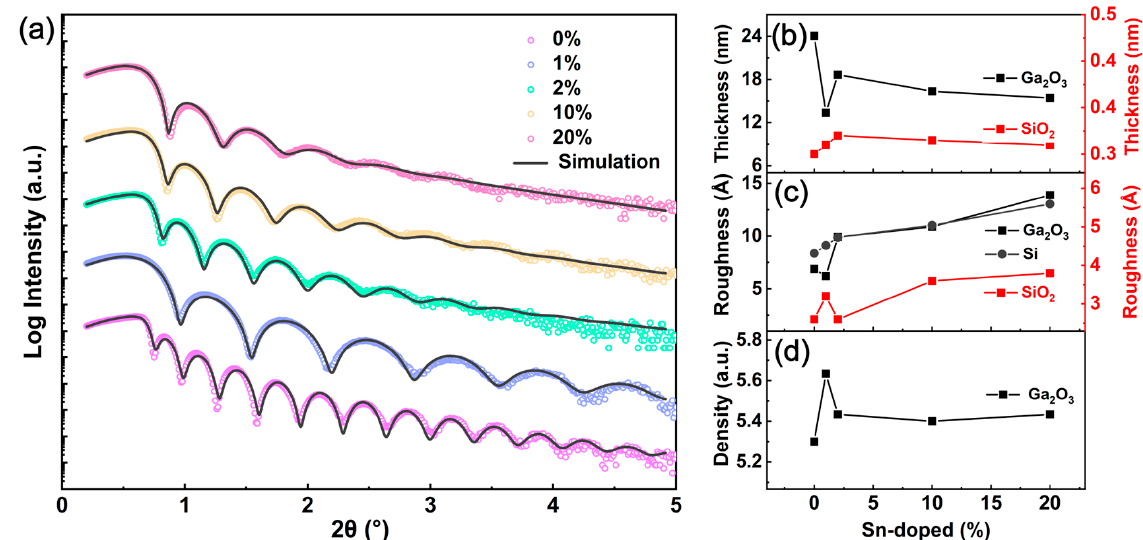
Figure 2. ( a ) Measured XRR (hollow circles) of the Ga 2 O 3 film with different Sn concentrations compared to the simulated data (black curves). Thickness ( b ), RMS roughness ( c ), and density ( d ) of the films as a function of the Sn concentration.